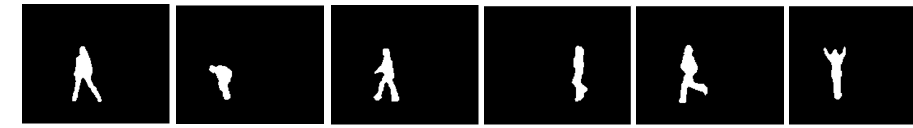
Figure 2. Exemplary foreground masks from the Weizmann database [21].